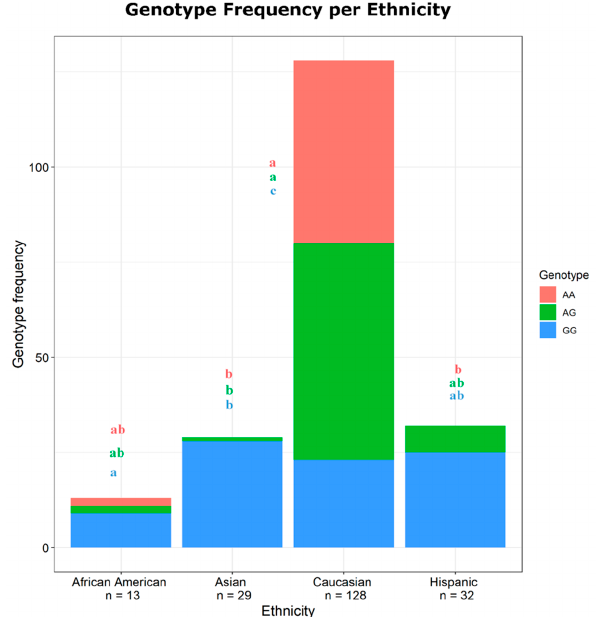
Figure 2. Genotype frequencies among ethnicities were compared with a Fisher’s exact test. Pairwise testing between ethnicities were conducted using the Benjamini–Hochberg adjustment for multiple comparisons. Ethnicities with different letters have significantly different frequencies for the AA (red), AG (green), or GG (blue) genotypes ( p < 0.05).